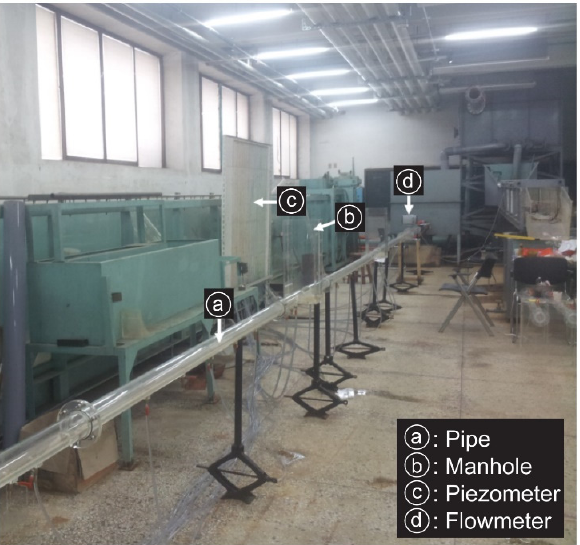
Figure 2. Experimental apparatus for the estimation of head loss coefficients.